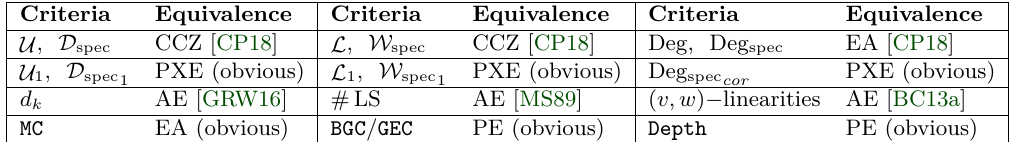
Table 4: Known function equivalence that preserves particular criteria